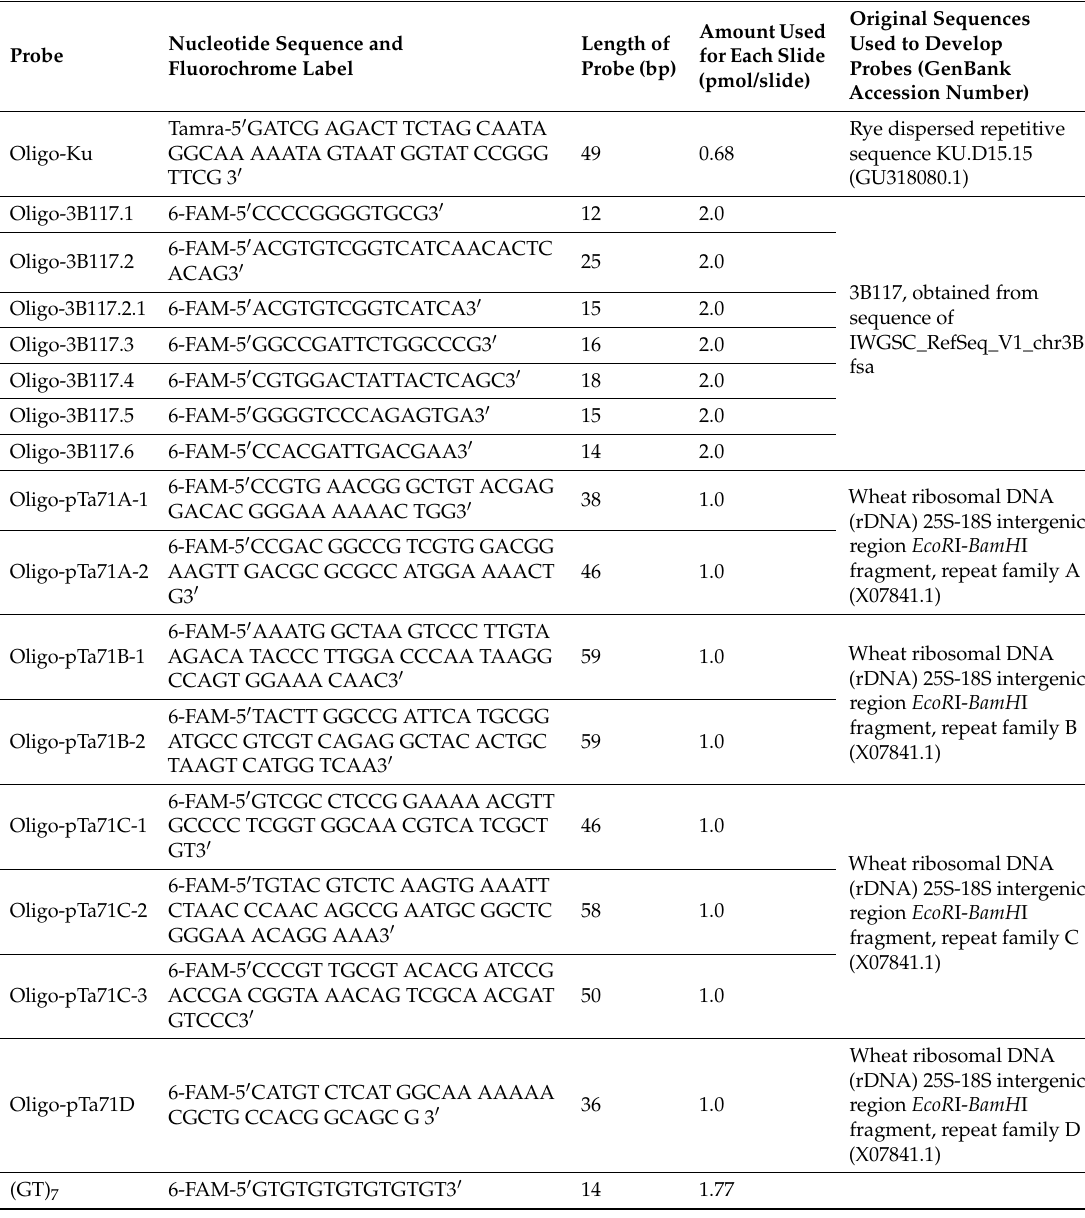
Table 1. Oligonucleotide probes for ND-FISH